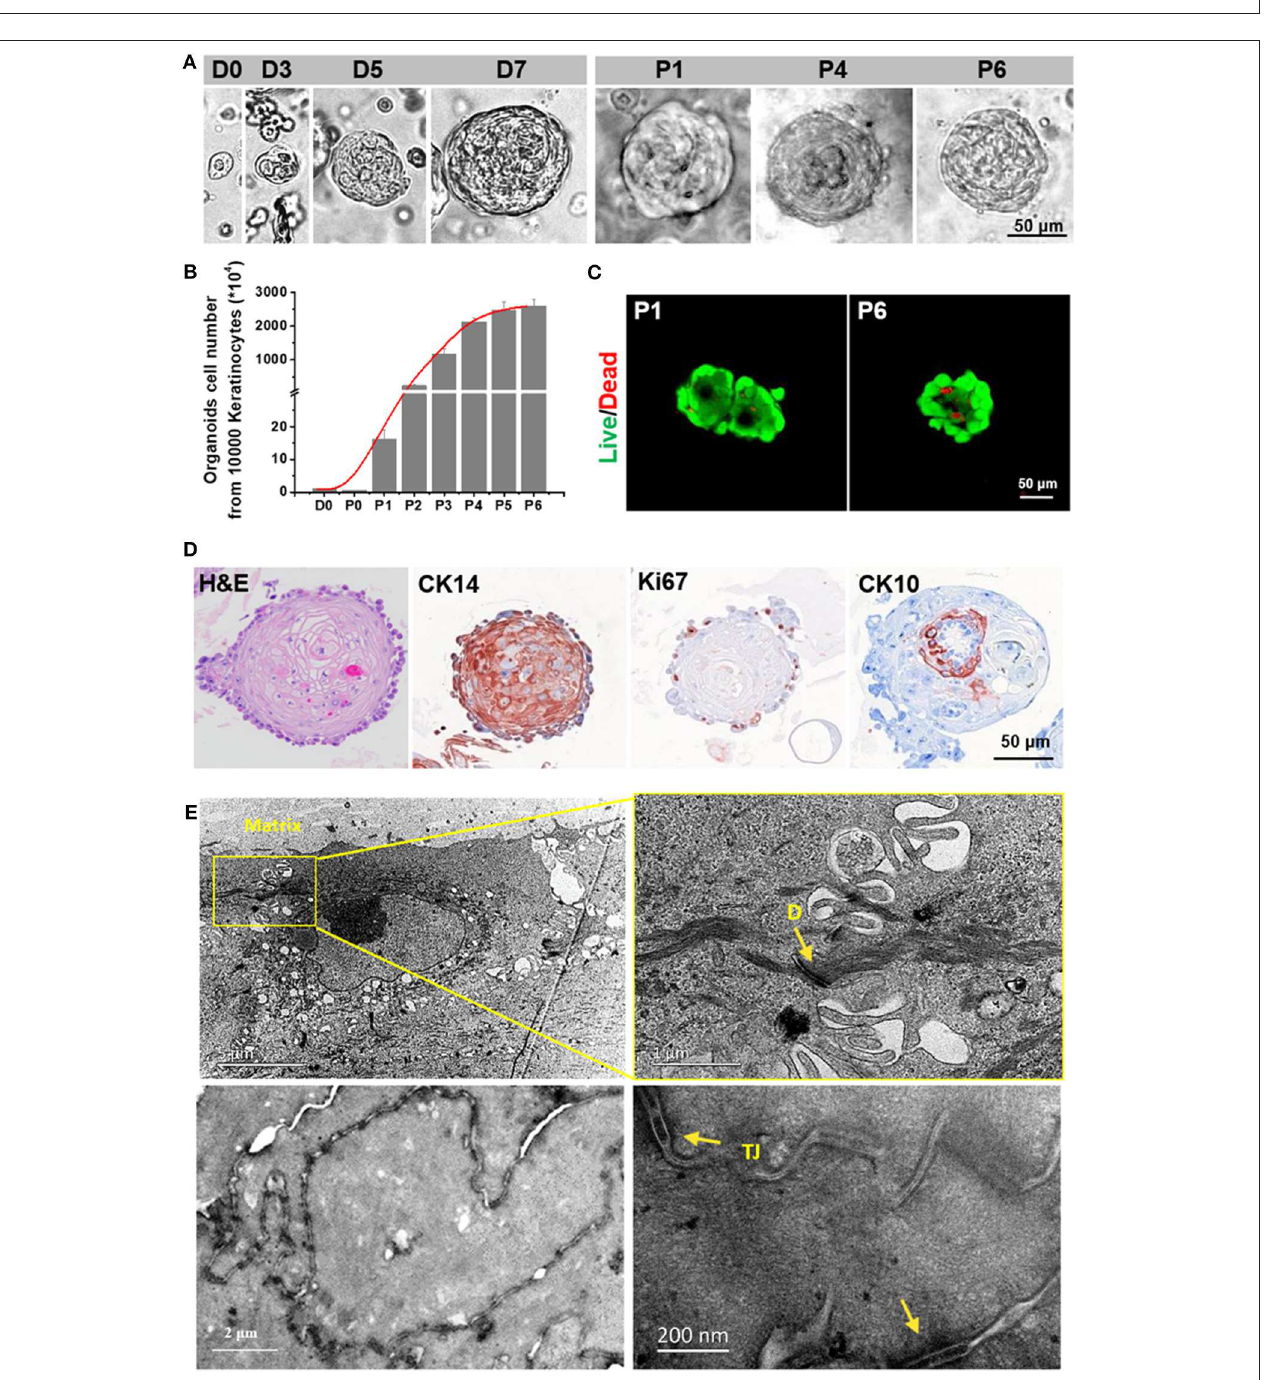
FIGURE 3 | suspended and sprayed in different media containing Matrigel. (D) The bright field and fluorescent images of HaCaT organoids in Matrigel after being delivered by spray vs. pipette; the numbers in the photos indicate the percentages of live cells in the organoids. (E) The tubular network formation by HUVEC cells after being delivered by spray vs. pipette is noted along with information on the extracted skeletons of tubular networks analyzed by ImageJ (F) and with the parameters, including identified segments, nodes and meshes, of tube formation.